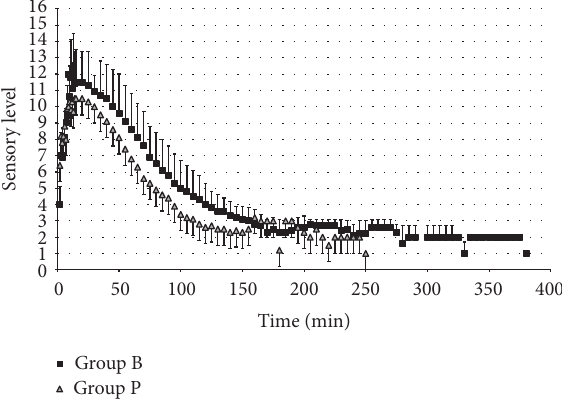
Figure 1: Onset and resolution of the sensory